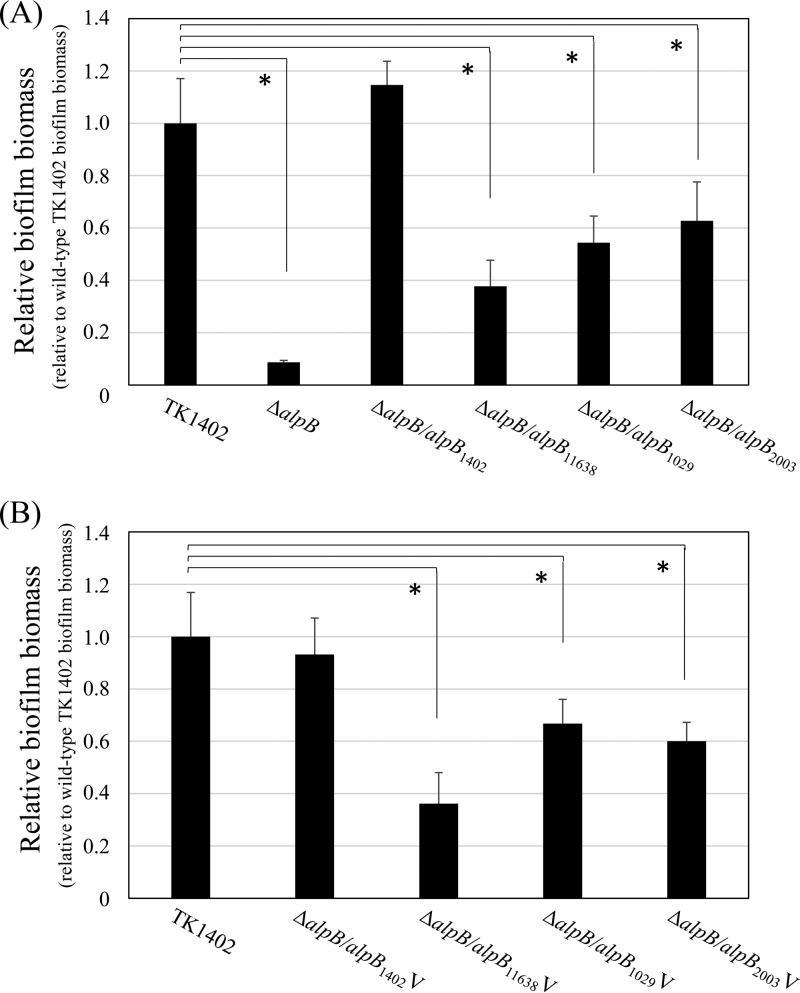
Biofilm formation by wild-type TK1402 (TK1402) and the alpB strains restored with alpB from other strains. (A) Intact alpB from strains TK1402, NCTC11638, TK1029, and KR2003 was introduced into a TK1402ΔalpB strain (TK1402ΔalpB/alpB1402, TK1402ΔalpB/alpB11638, TK1402ΔalpB/alpB1029, or TK1402ΔalpB/alpB2003), and biofilm-forming ability was analyzed. (B) The alpB variable region from strains TK1402, NCTC11638, TK1029, and KR2003 was inserted into the TK1402 alpB region and introduced into a TK1402ΔalpB strain (TK1402ΔalpB/alpB1402V, TK1402ΔalpB/alpB11638V, TK1402ΔalpB/alpB1029V, or TK1402ΔalpB/alpB2003V). The biofilm-forming abilities of these restored strains were analyzed. Biofilm quantity was calculated relative to that for wild-type TK1402, which was set to 1.0. All of the results were expressed as the means ± 1 standard deviation from at least three independent experiments. An asterisk indicates significant difference (P < 0.05) relative to the level of wild-type biofilm biomass.